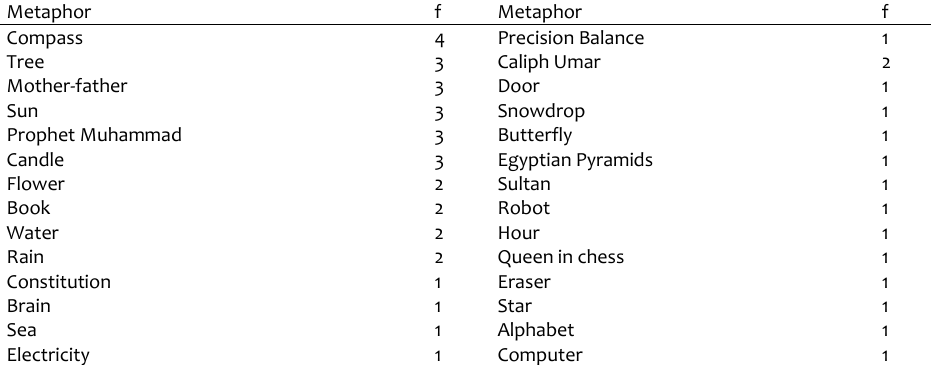
Table 2 . Ethical teacher metaphors according to the prospective teachers